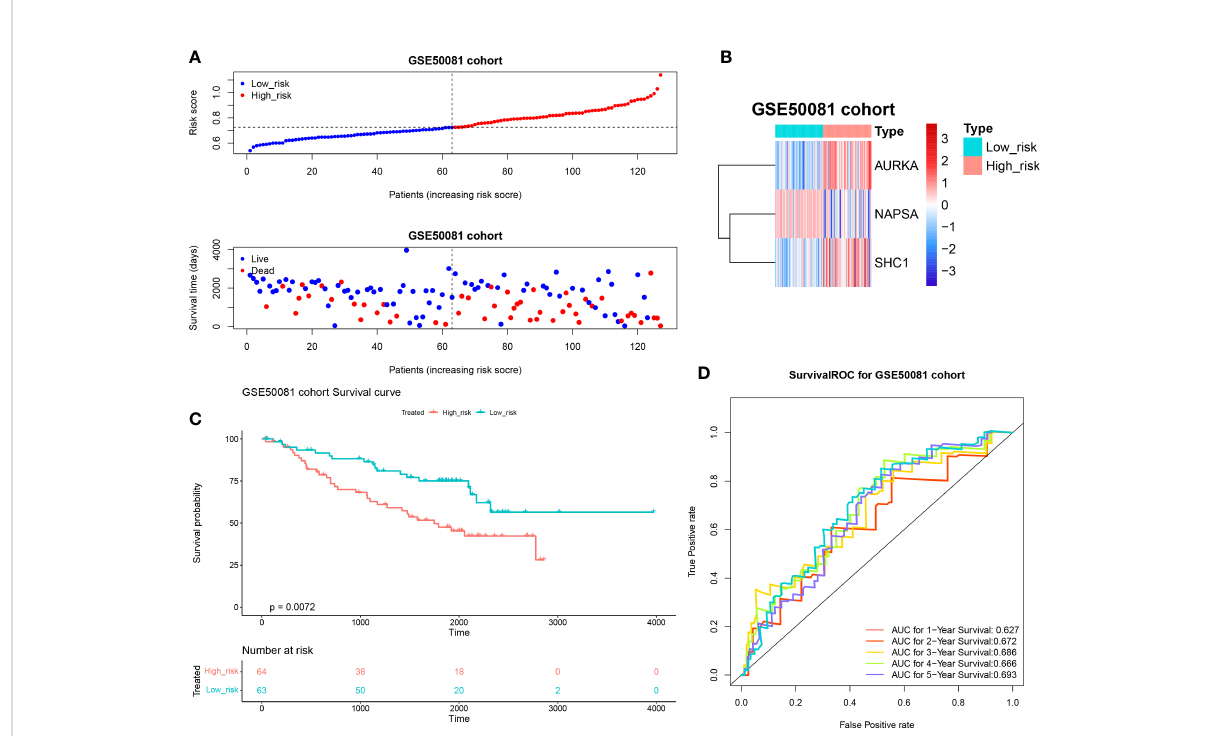
FIGURE 6 Validation of the autophagy-related risk score model (external GSE50081 dataset). (A) The validation set high and low-risk group curves. (B) Heat map of model gene expression in the high and low-risk groups in the validation set. (C) KM survival curves for the high and low-risk groups in the validation set. (D) Validation set survival ROC